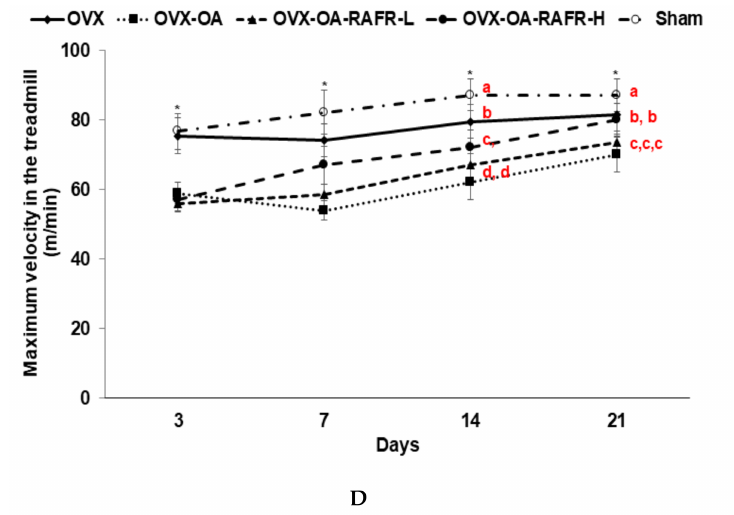
Figure 4. Gross observations of osteoarthritis symptoms and pain-related behaviors at 3, 7, 14, and 21 days after monoiodoacetate (MIA)-injection Ovariectomized (OVX) rats were divided into four groups: (1) MIA injection into the knee joint and fed a high-fat diet containing 0.23% rice + 0.018% AFR diet (RAFR-L). (2) MIA injection into the knee joint and fed a high-fat diet containing 0.69% rice + 0.053% AFR diet (RAFR-H). (3) MIA injection into the knee joint and fed a high-fat diet containing 0.053% cellulose (OA-control). (4) Saline injection into the knee joint and fed a high-fat diet containing 0.053% cellulose (non-OA control). Sham rats had the same diet as the control and received a saline injection (normal-control). At the beginning of the eighth week, an articular injection of monoiodoacetate (MIA) into the right knee was performed in all OVX groups except the normal-control group. The assigned diets were provided for an additional three weeks. During the gross observations of osteoarthritis symptoms, the swelling ( A ) and limping ( B ) scores in the right knee were measured. Di ff erences in the weight distribution of the right hind paws ( C ) were measured via an incapacitance tester and the maximum running velocity on a treadmill ( D ) as indicators of knee pain. Each data point and error bar represent the mean ± SD ( n = 10). * Significant treatment e ff ect by repeated measures of a two-way ANOVA test at p < 0.05. ‡ Significant time e ff ect by repeated measures of a two-way ANOVA test at p < 0.05. a,b,c,d Values of the bars with di ff erent superscripts were significantly di ff erent among groups as per the Tukey test at p <